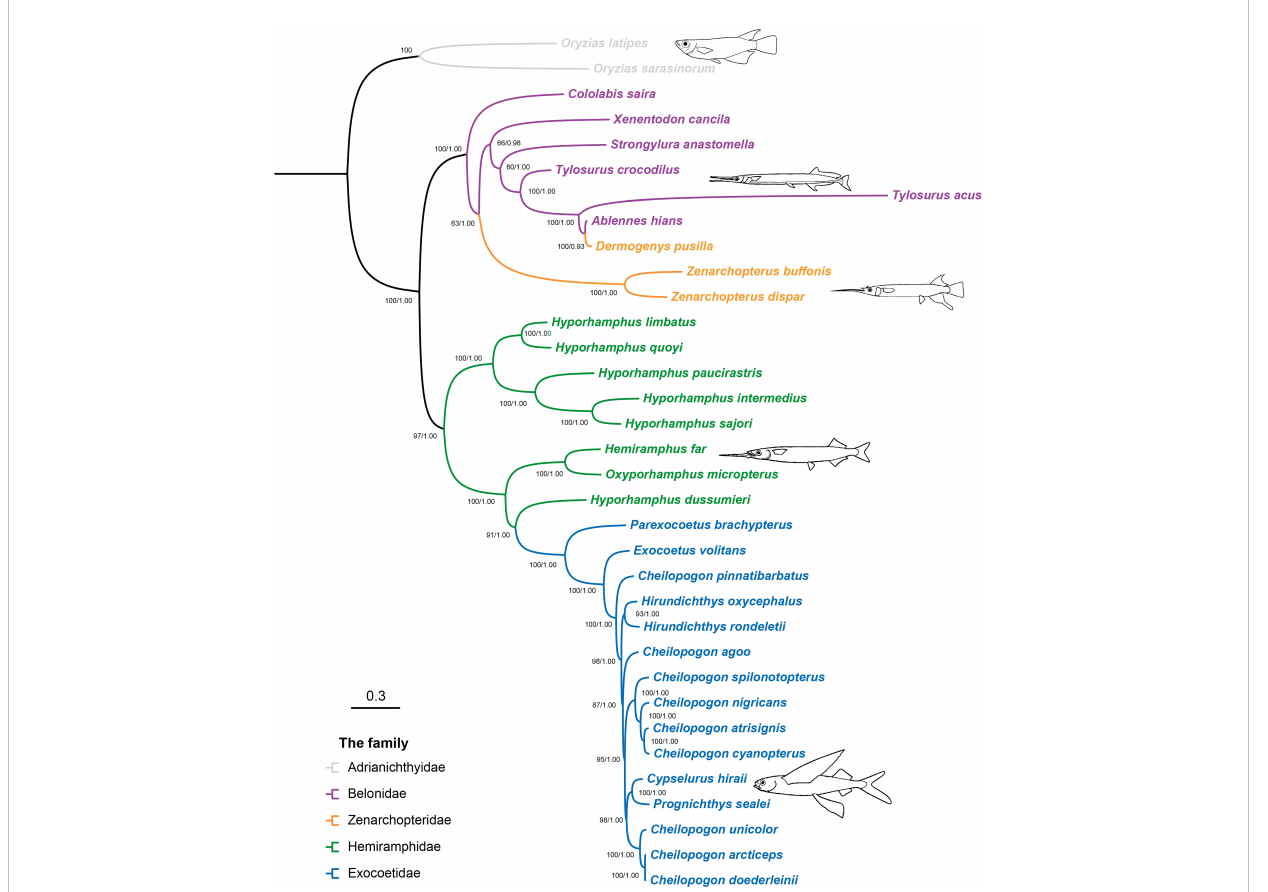
FIGURE 1 Phylogenetic trees of Beloniformes fi shes inferred from the 34 mitogenomes of Beloniformes, reconstructed using the maximum-likelihood and Bayesian inference methods. Node labels represent Bootstrap support values/Bayesian posterior probability. The ML tree and BI tree were shown in Supplementary Figures S2, S3,